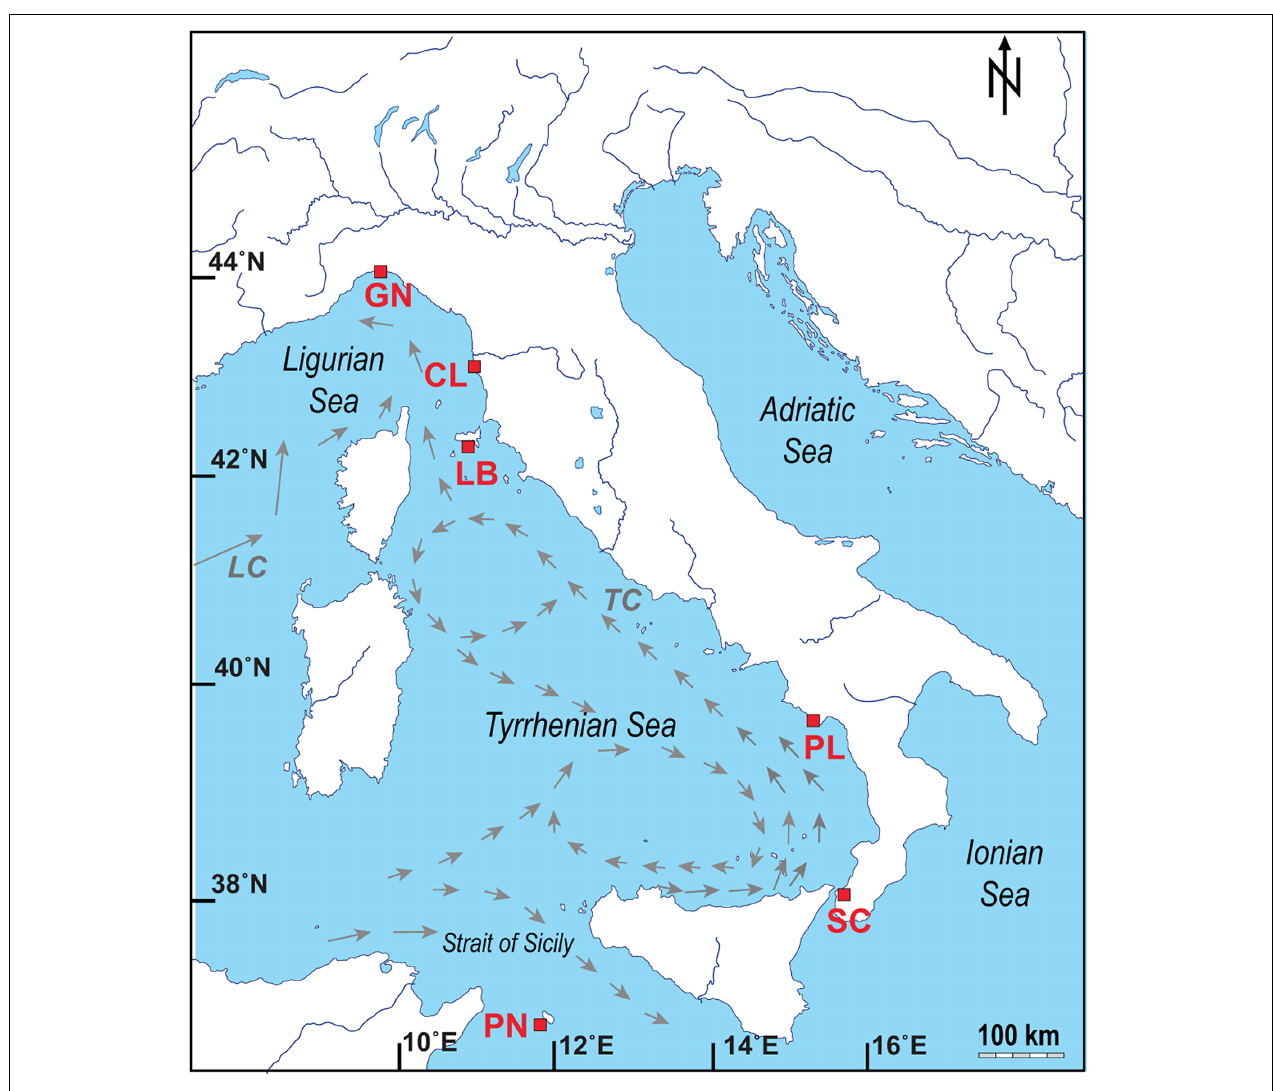
FIGURE 1 | Map of the Italian coastline indicating the sites where the corals and seawater samples were collected, with pattern of the main currents for the Ligurian Sea and Tyrrhenian Sea (modified from Silenzi et al., 2005; LC: Ligurian–Provencal Current; TC: Tyrrhenian Current). Abbreviations and coordinates of the site in decreasing order of latitude: GN Genova, 44 ◦ 20 (cid:48) N, 9 ◦ 08 (cid:48) E; CL Calafuria, 43 ◦ 27 (cid:48) N, 10 ◦ 21 (cid:48) E; LB Elba Isle, 42 ◦ 45 (cid:48) N, 10 ◦ 24 (cid:48) E; PL Palinuro, 40 ◦ 02 (cid:48) N, 15 ◦ 16 (cid:48) E; SC Scilla, 38 ◦ 01 (cid:48) N, 15 ◦ 38 (cid:48) E; PN Pantelleria Isle, 36 ◦ 45 (cid:48) N, 11 ◦ 57 (cid:48)